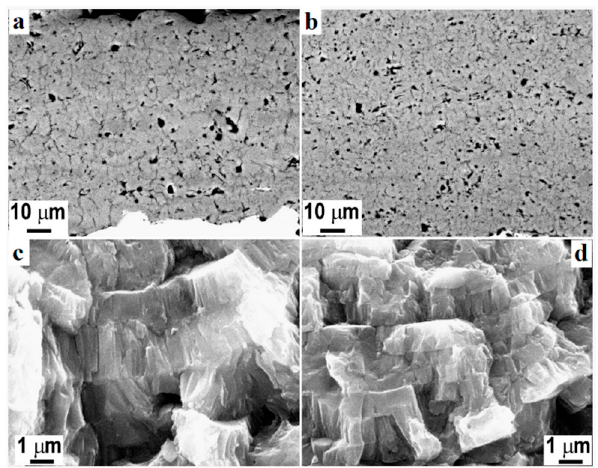
Figure 4. Polished cross-section of atmospheric plasma spray (APC) ( a ) and high-velocity oxy-fuel plasma coating (HVOF) ( b ) TiO2 coatings and respective fracture sections ( c , d ) [80].